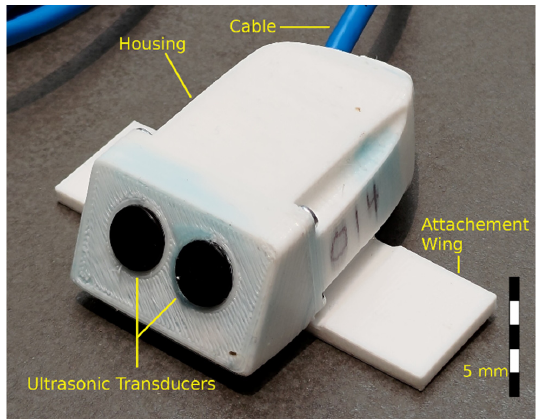
Figure 5. Picture of the velocity sensor with approximate scale overlayed. Key external features of the sensor have been labelled. The sensor measures 75 mm by 44 mm by 25 mm without the optional attachment